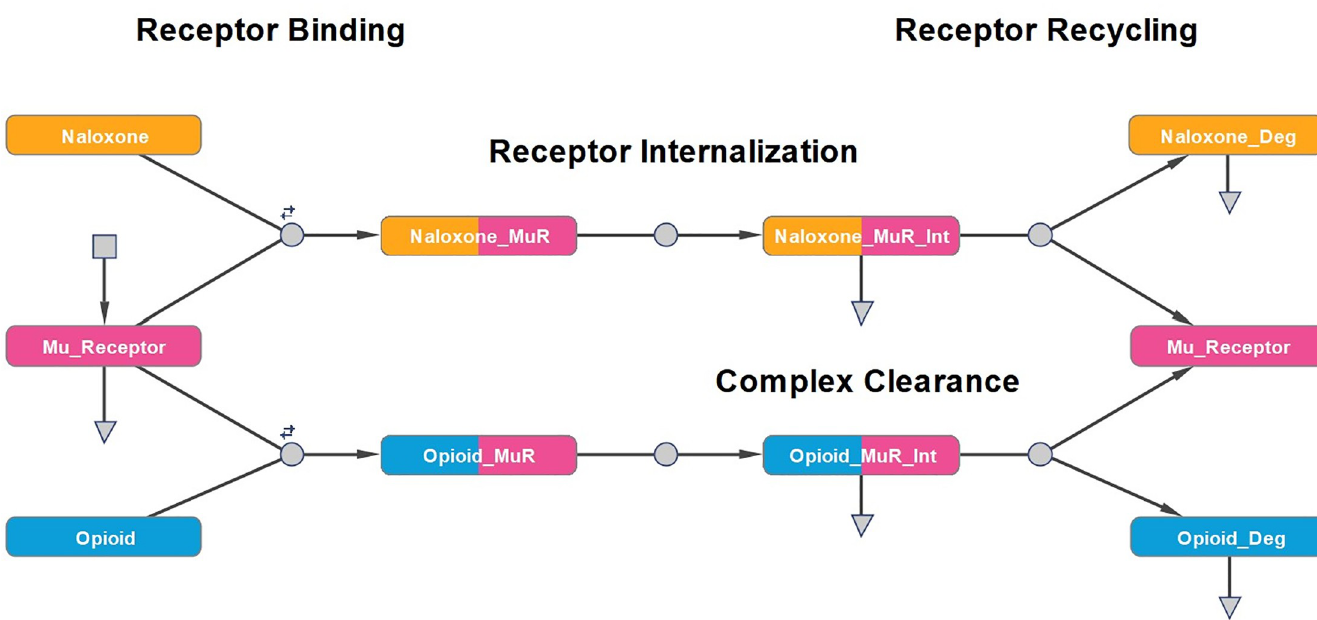
Fig 1. Graphical depiction of the mu receptor submodel. The model accounts for mu receptor synthesis and degradation, competitive binding to the receptor, internalization, recycling, and clearance.